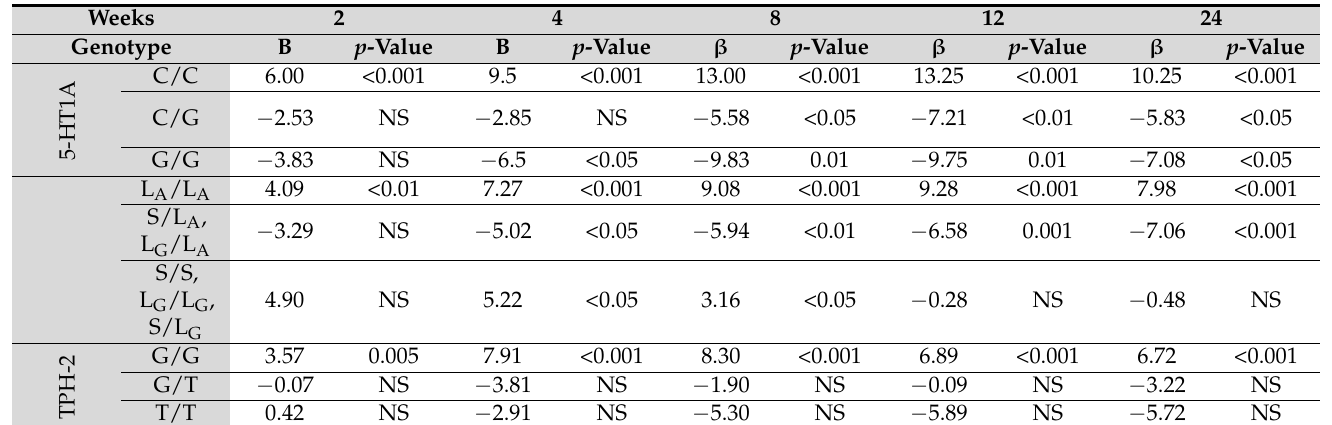
Table 4. Multilevel regression analyses indicating differences in MADRS score for each time point compared to baseline, with β indicating regression coefficient and p the level of significance for patients with genotypes of 5-HT1A, TPH-2, and functional 5-HTTPLR.